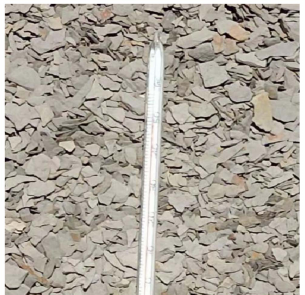
Figure 11. Outdoor temperature monitoring.